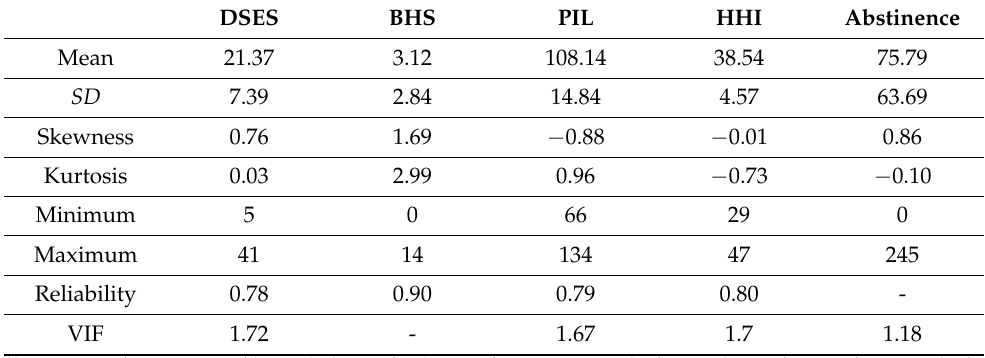
Table 2. Descriptive statistics ( n = 70).